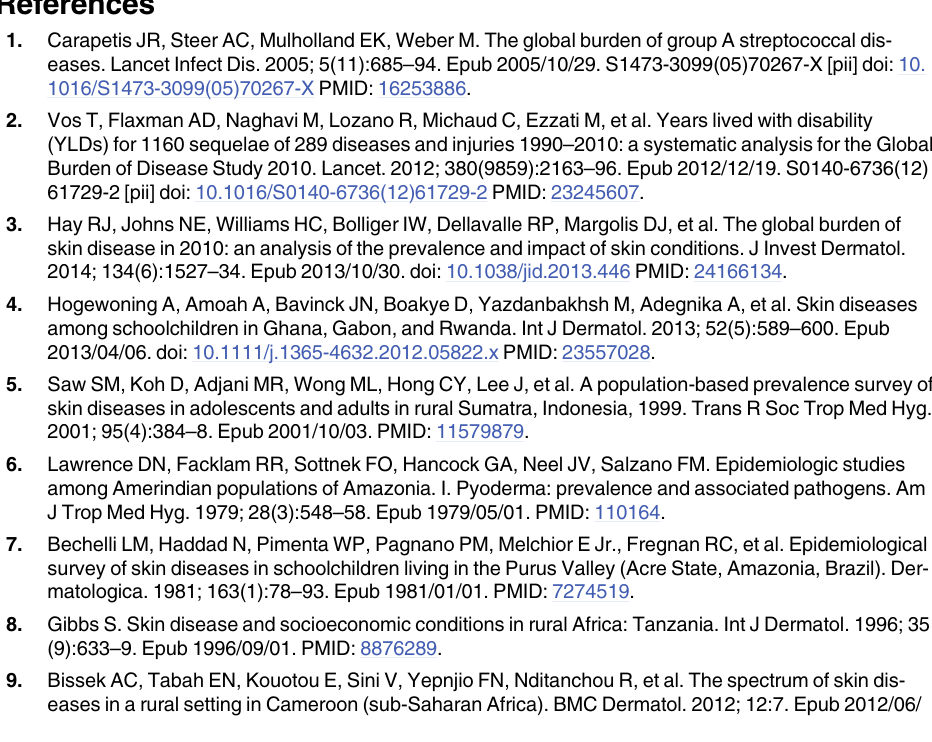
S1 Table. Overall and childhood pyoderma and scabies prevalence from 89